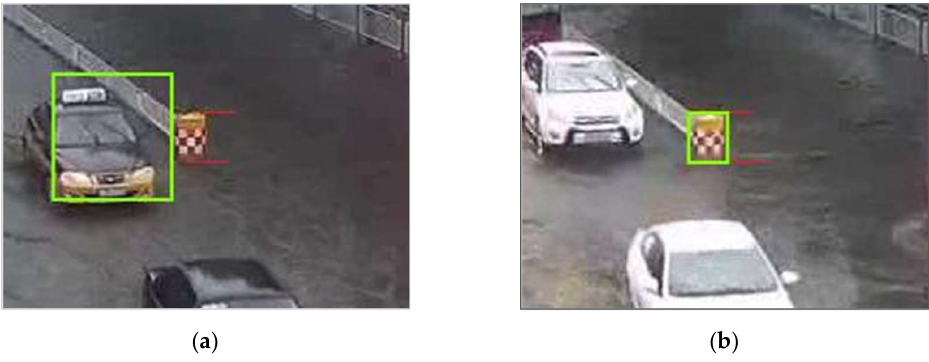
Figure 6. An example of one car being mistakenly recognized as a traffic bucket ( a ), and an example of the traffic bucket being correctly detected ( b ) using a relatively large size for the region of interest (RoI). The green box is the bounding box. Due to the low resolution of available video data, these images are not very clear.